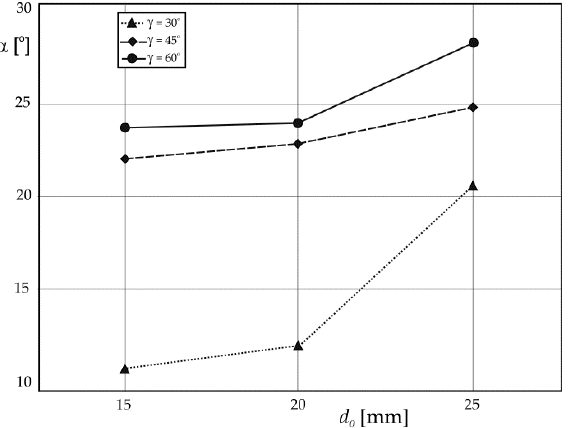
Figure 13. Influence of the outlet opening diameter of the atomizer on the spray angle for inserts of various designs [54].